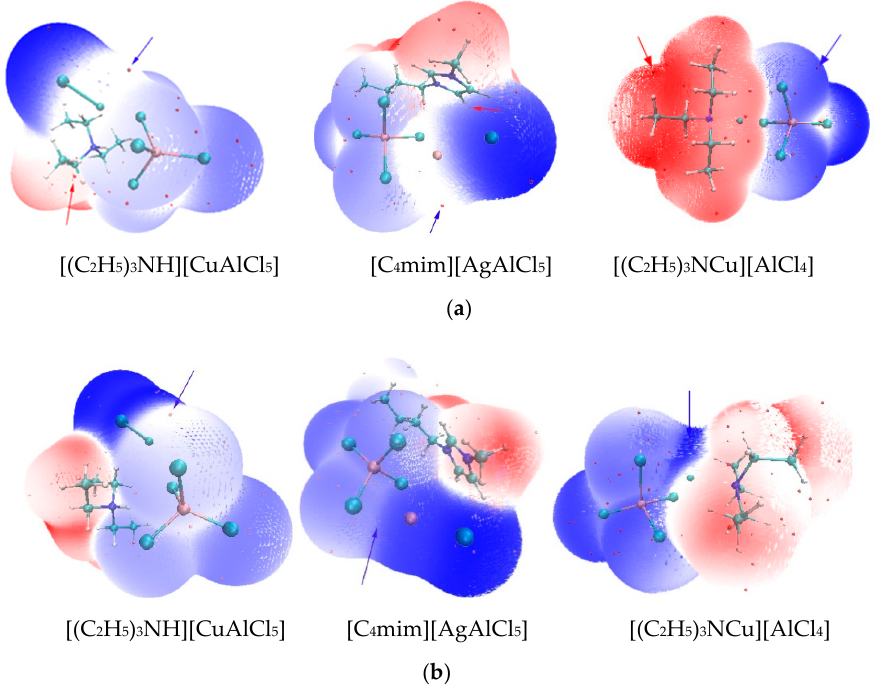
Figure 2. Molecular surface properties of mixed chlorometallate ILs: ( a ) electrostatic potential with a 0.001 a.u. contour of the electron density and the location of V s,max (red arrow) and V s,min (blue arrow) on the ILs; ( b ) average local ionization energy with a 0.001 a.u. contour of the electron density and 𝐼̅ s,min on the ILs (blue arrow).